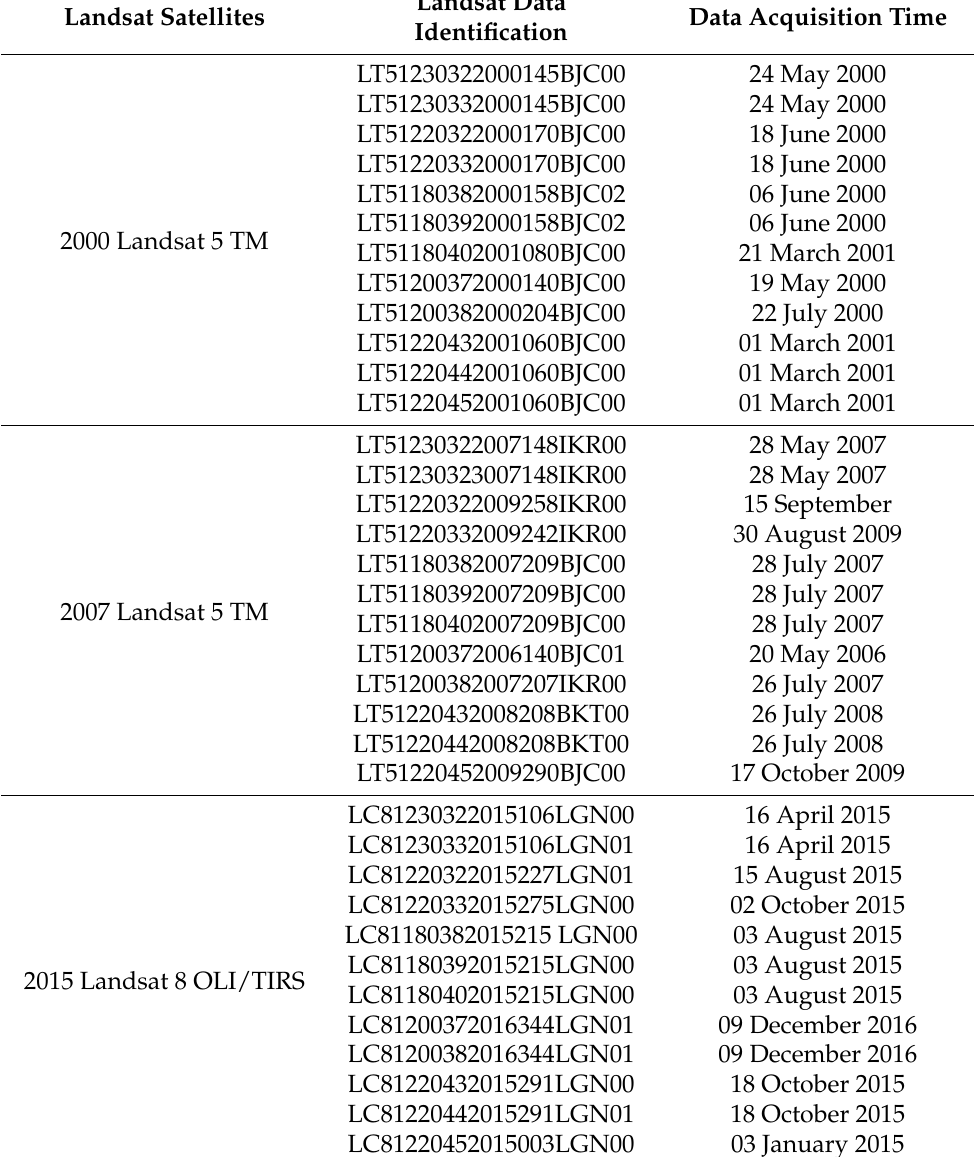
Table A1. Landsat 5 TM and Landsat 8 OLI/TIRS images information of the study area.